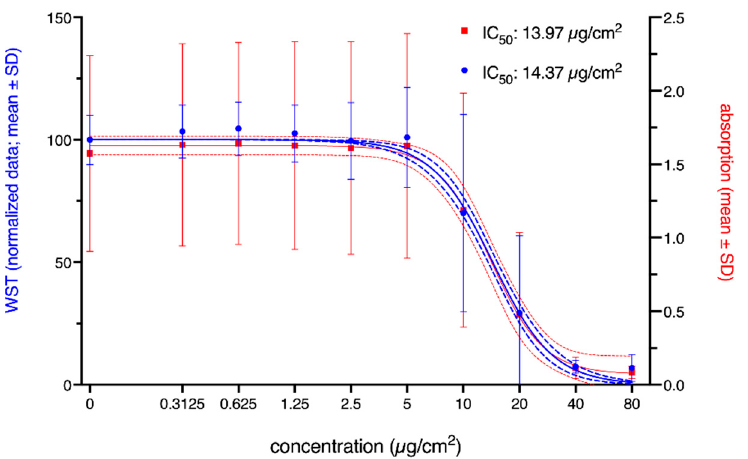
Figure 6. Viability of A549 cells, as indicated by the WST-1 assay, after 24 h of exposure to NM110 (ZnO). Both normalized data (blue) and corrected absorption (red) are given. Solid lines represent the nonlinear regression based on the calculated mean values; dashed and dotted lines represent the corresponding 95% confidence bands. The calculated IC 50 values are given in the figure legend. The concentration is the administered concentration of the ENMs based on the initial dispersion.